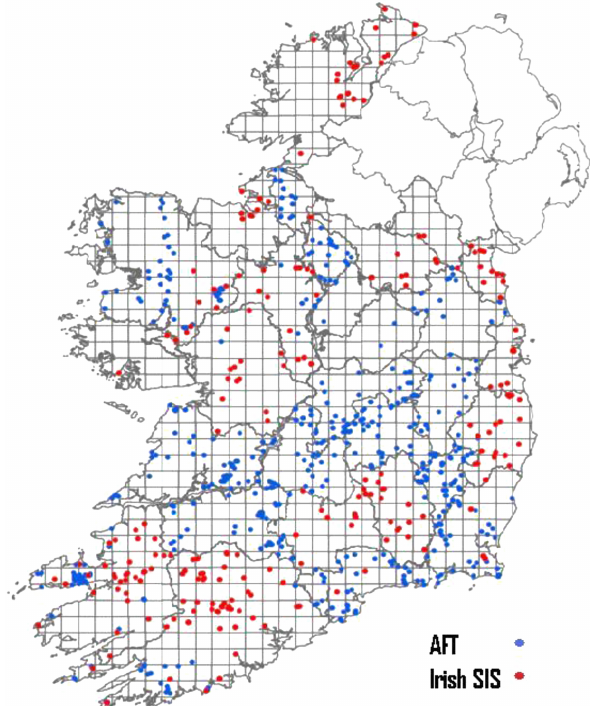
Figure 1. Location of Irish soil information system (Irish SIS) and An Foras Talúntais (AFT) soil profile pits. The blue circles corre- spond to AFT and the red circles correspond to Irish